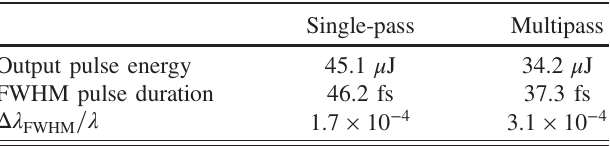
TABLE III. Properties of 2.5 nm FEL output radiation. For the multipass HOK HGHG resonator-radiator simulations starting from an external seed laser, the pulse energy, the FWHM pulse duration, and the relative FWHM bandwidth are the average ones in the steady-state regime of the system.